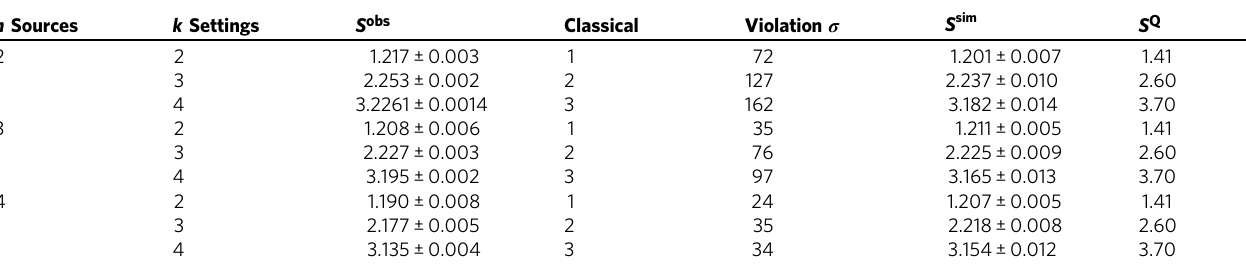
Table 2 Experimental results for different number of sources n and measurement settings k